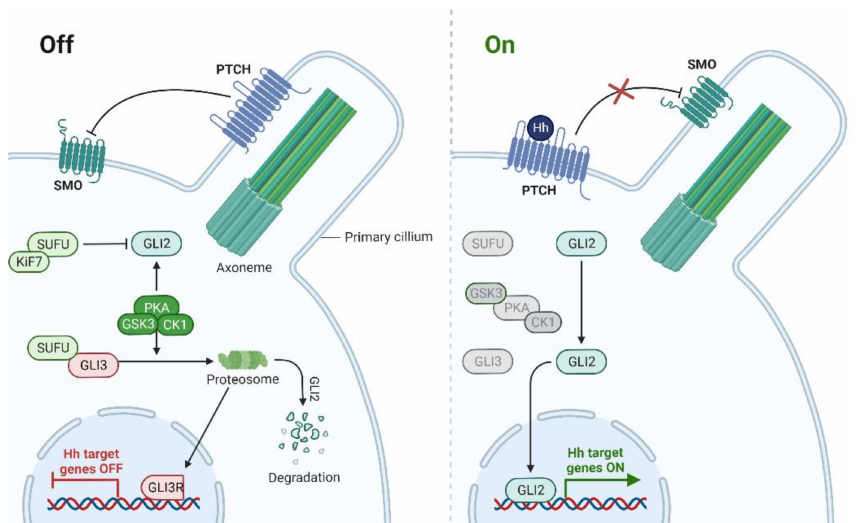
Figure 1. Outlook on primary cilia and Hedgehog signalling pathway [87]. In the absence of a Hh ligand, GLI is phosphorylated by PKA, GSK3 β , and CK1, leading to GLI repressor formation and arrest of the pathway. When Hh ligands are present, Smoothened is phosphorylated, SUFU inhibition is removed, and the GLI activator induces targeted genes